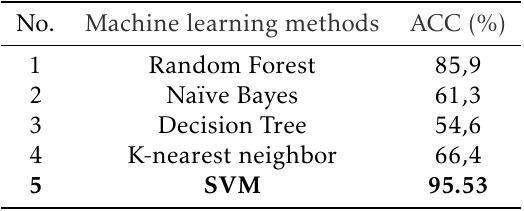
Table 4. Classification accuracy of other machine learning methods for classification of 17 rice